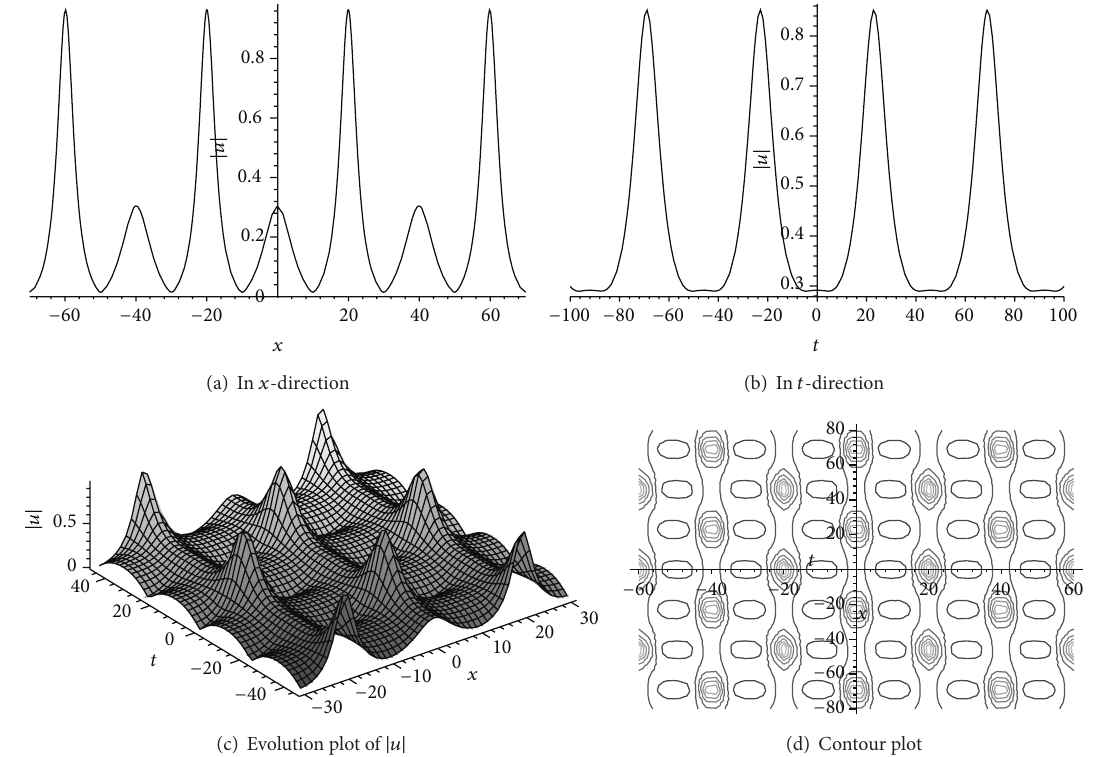
Figure 1: Doubly periodic wave solution 𝑢(𝑥,𝑡) given by (21) with 𝛿 = 0.2 , 𝛽 = 0.4 , 𝜆 = 0.2 , 𝑘 = 0.8 , and 𝑘 1 = 0.2 .